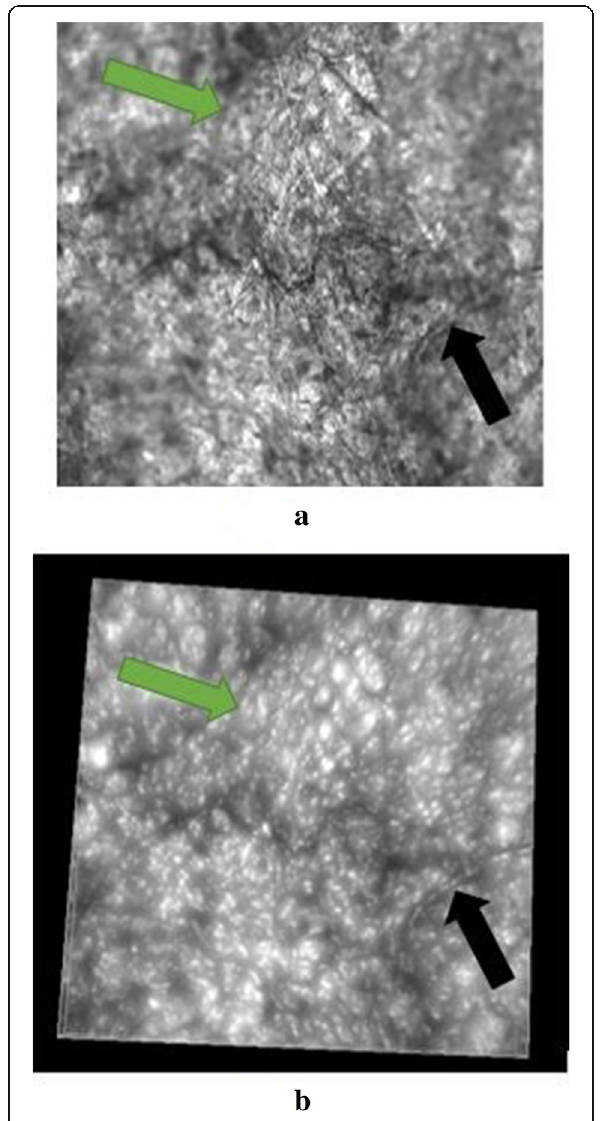
Fig. 8 Blue Cello Butterflow pen intersecting strokes. a 2D figure.